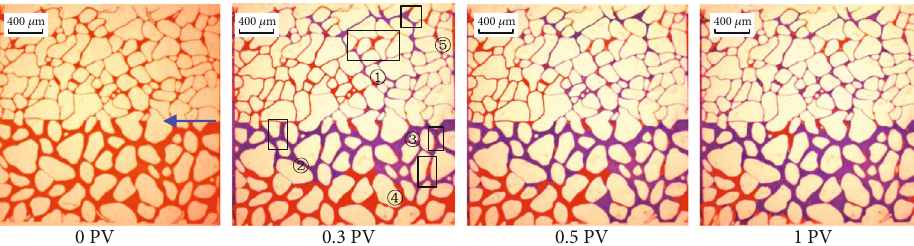
Figure 5: Distribution of residual oil under polymer surfactant fl ooding with a permeability ratio of 6 ( ① cluster, ② oil drop, ③ oil fi lm, ④ columnar, and ⑤ blind end; the red part represents oil; the blue part represents the displacement fl uid; the injection direction of the displacement agents is from right to